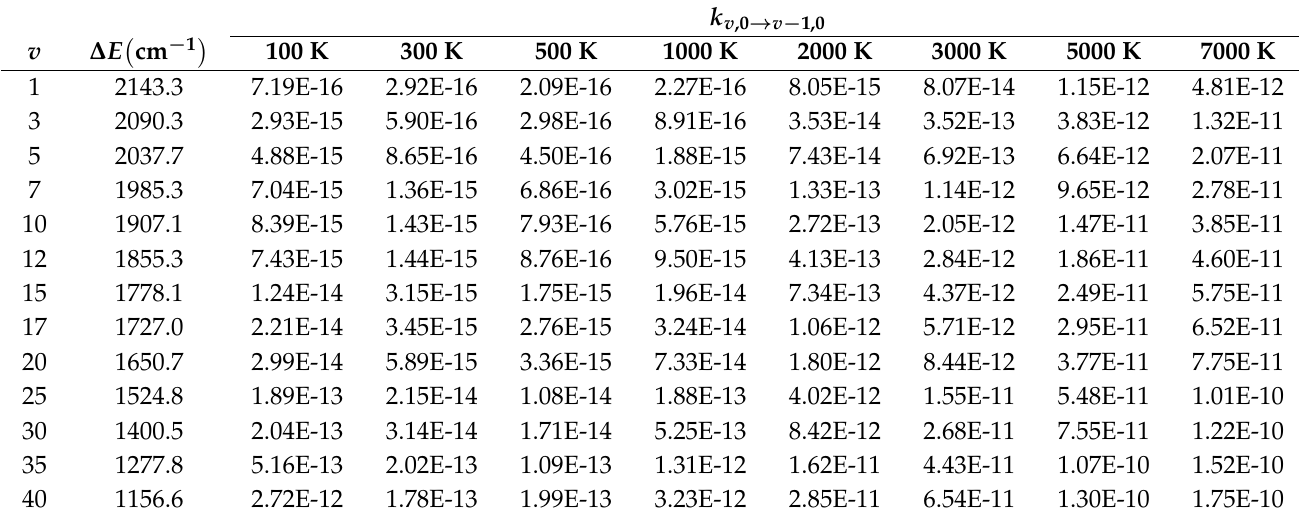
Table 8. Single quantum V–T/R rate coefficients (in cm 3 /s) for the transition CO ( v ) + N 2 ( 0 ) → CO ( v − 1 ) + N 2 ( 0 ) + ∆ E .